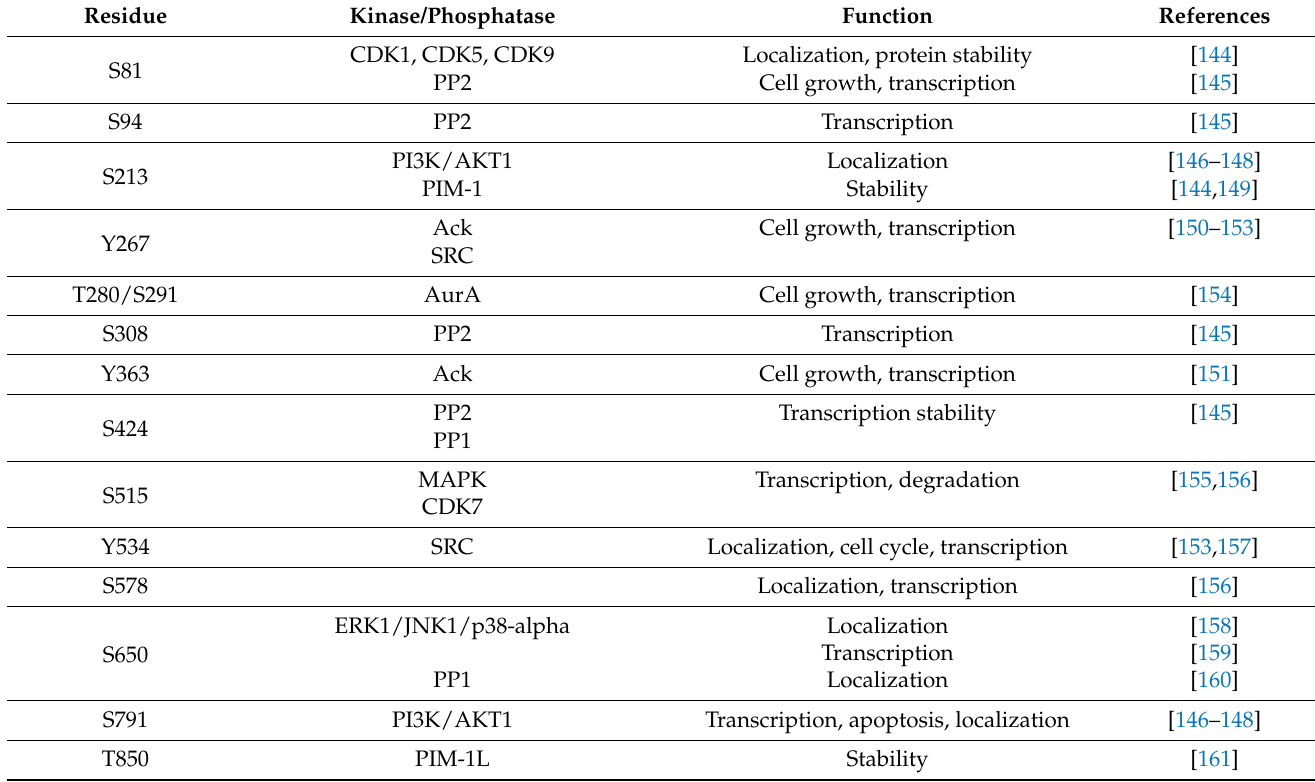
Table 2. Phosphorylated residues of the AR and their functional roles. Reprinted from the paper “Posttranslational Modification of the Androgen Receptor in Prostate Cancer” by Van der Steen, Tindall and Huang; published in International Journal of Molecular Sciences (publisher: MDPI), 2013 [128].